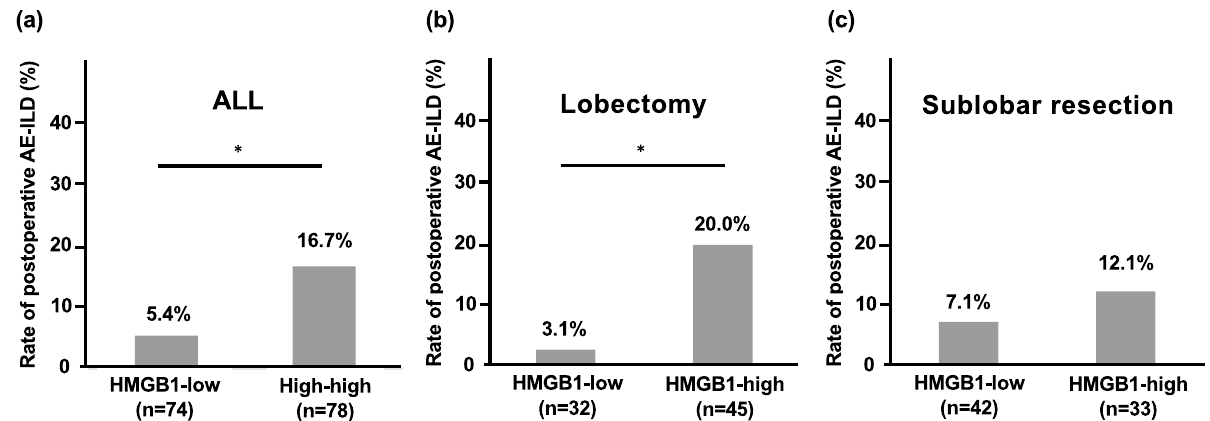
Figure 2. The incidence of postoperative AE-ILD based on HMGB1 and type of surgical intervention. The cut- off level for HMGB1 was 3.82 ng/mL. In the entire population, the incidence of postoperative acute exacerbation of interstitial lung disease (AE-ILD) in patients with HMGB1-high was significantly higher than that in patients with HMGB1-low (a) . It was also significant in the subgroup treated with lobectomy (b) , but not in those treated with sublobar resection (c) . * P < 0.05 using Pearson’s chi-squared